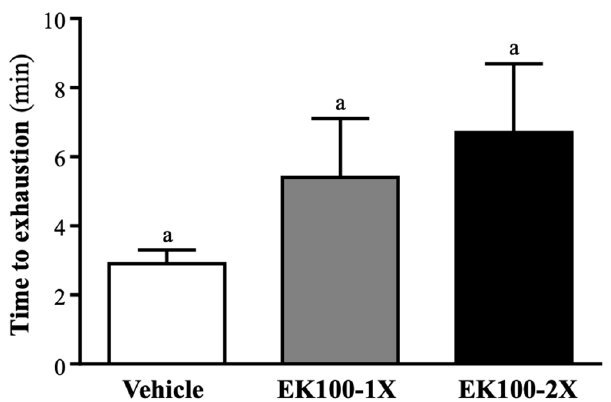
Figure 2. Effect of EK100 supplementation on swimming exercise performance. Mice were supplemented with vehicle, 10 and 20 mg/kg of EK100 for six weeks. One hour after the last administered dose, the mice were subjected to an exhaustive swimming exercise with a load equivalent to 5% of the mouse’s body weight attached to its tail. Data is expressed as mean ± SEM ( n = 8 mice). Statistical analysis was done by using one-way ANOVA.